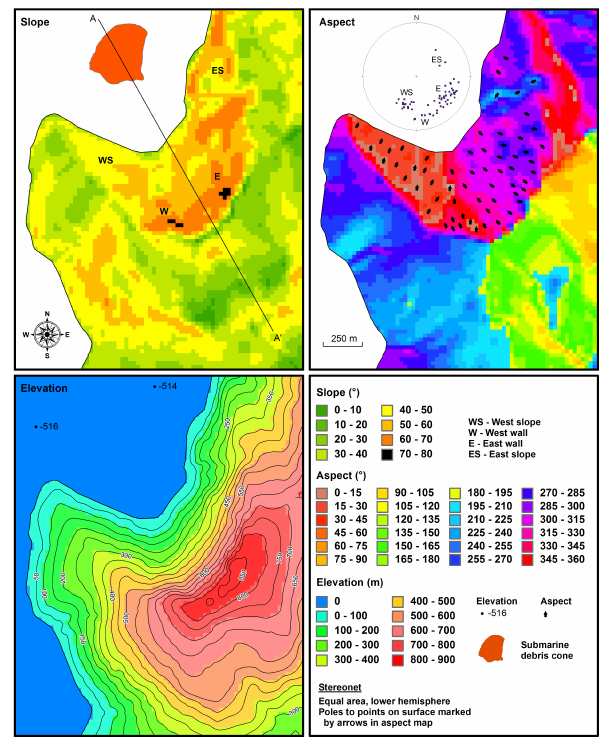
Figure 5. Slope and aspect maps. The stereonet included with the aspect map shows the 3-D shape of the slope.